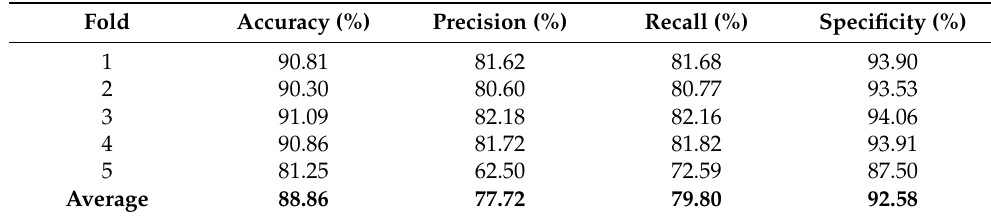
Table 5. Classification performance per ‐ fold for the test CXR images using LBP ‐ based SVM. Fold Accuracy (%)